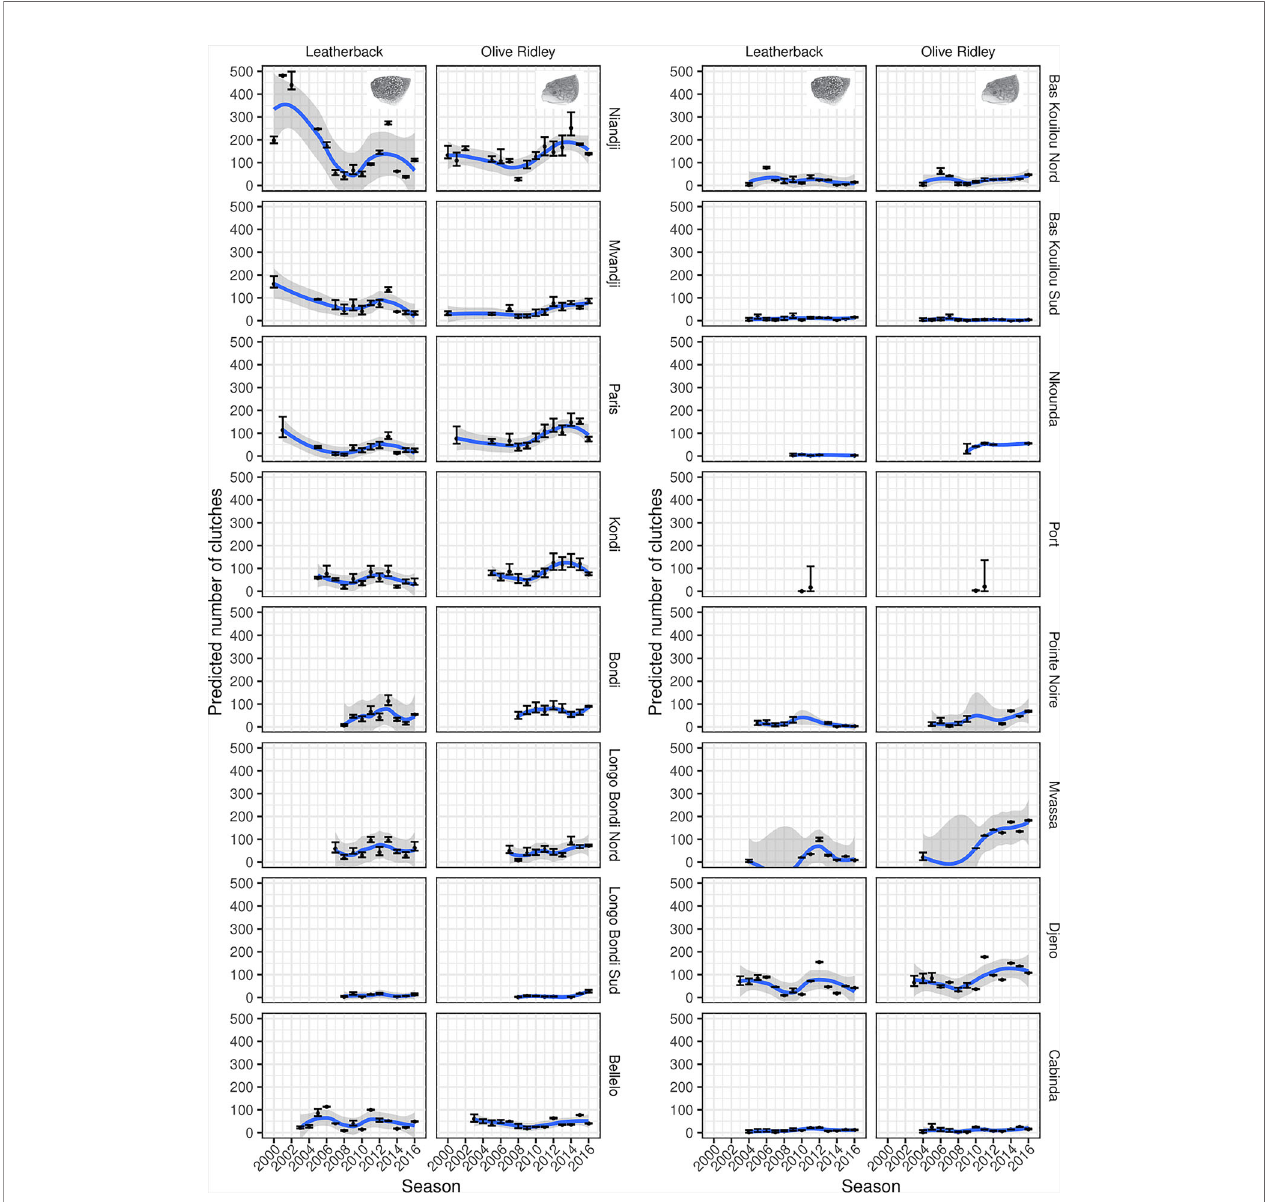
FIGURE 2 | Total predicted number of clutches in each site/season/species combination. Points correspond to posterior predictive means and error bars to 95% prediction intervals. The trend lines correspond to loess-smoothed fi ts through the posterior predictive means, with the grey ribbons depicting the 95% con fi dence intervals for the smoothed fi ts. This plot corresponds to Figure S3 in the supplemental material which shows the results of a sensitivity analysis where we used a less informative range on the peak nesting effort to determine the impact of our prior